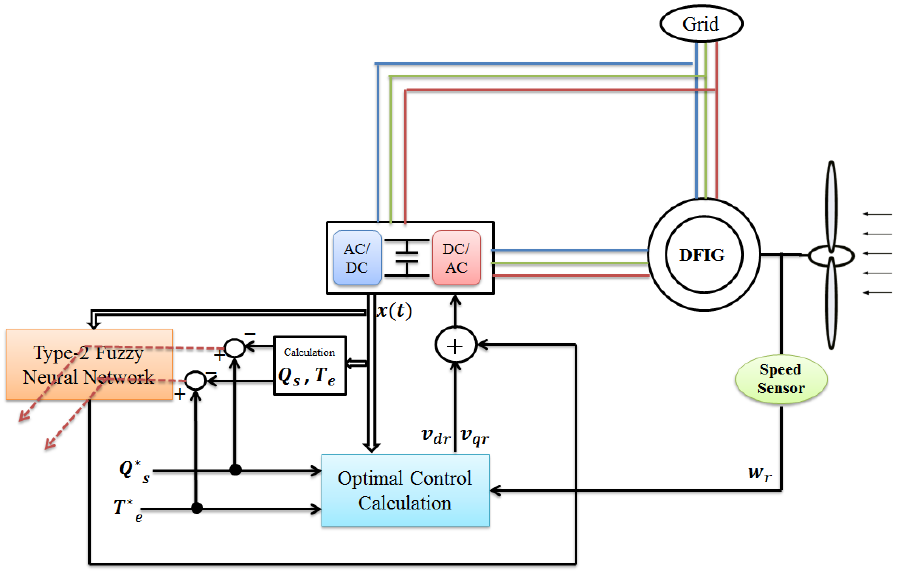
Figure 3. The proposed control system for DFIG.